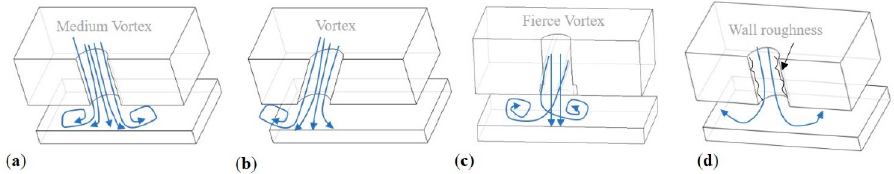
Figure 6. Schematic diagram of typical impingement cooling: ( a ) cylinder hole; ( b ) inclined hole; ( c ) swirling hole; ( d ) AM hole.